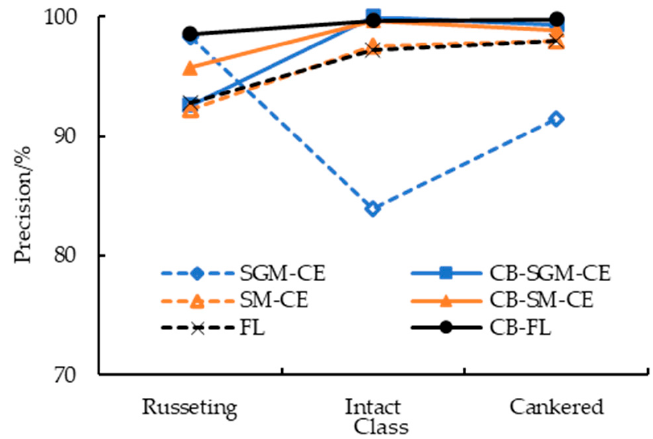
were carried out, respectively. The results are shown in Figures 6–8.